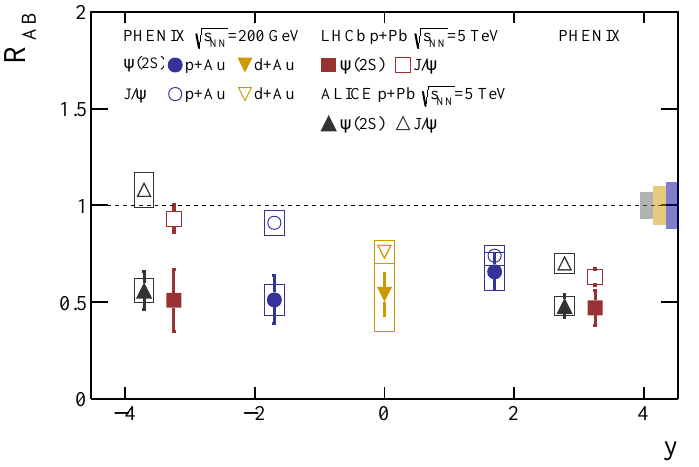
Figure 7. Nuclear modification measurements for J / ψ and ψ (2S) in p + Au and p + Pb collisions at RHIC and LHC energies [51]. Reprinted with permission from American Physical